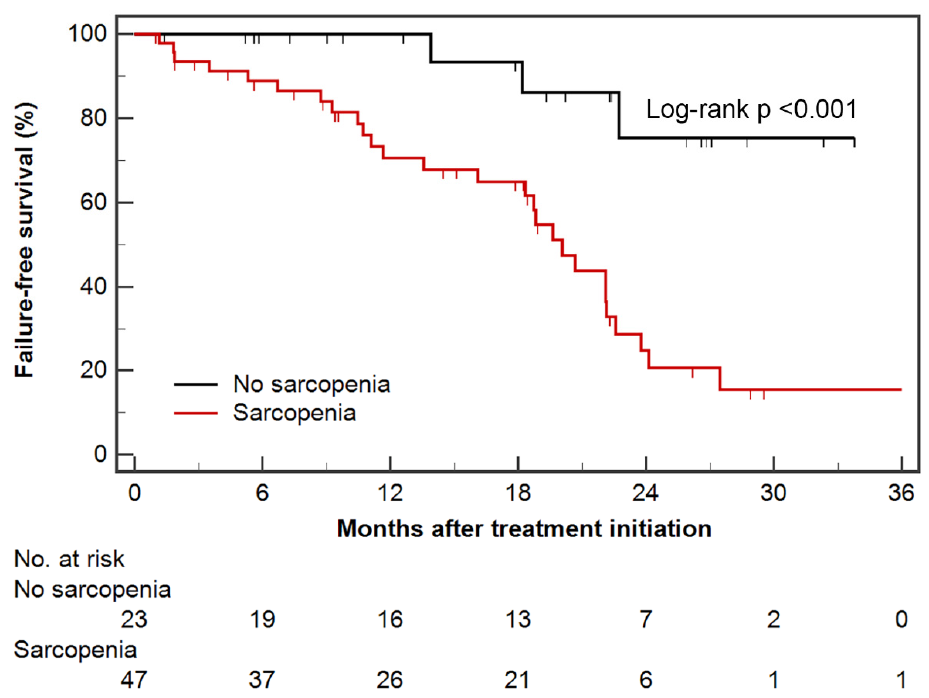
Figure 2. Kaplan–Meier estimates of failure-free survival according to sarcopenic status. Censored data are marked at each line.